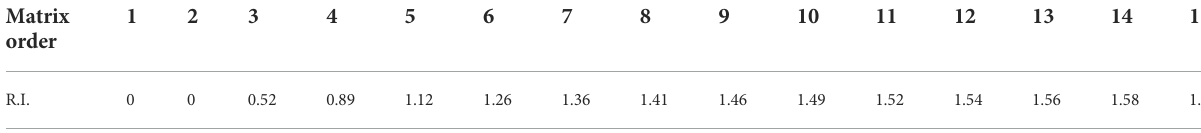
TABLE 4 Average random consistency index.